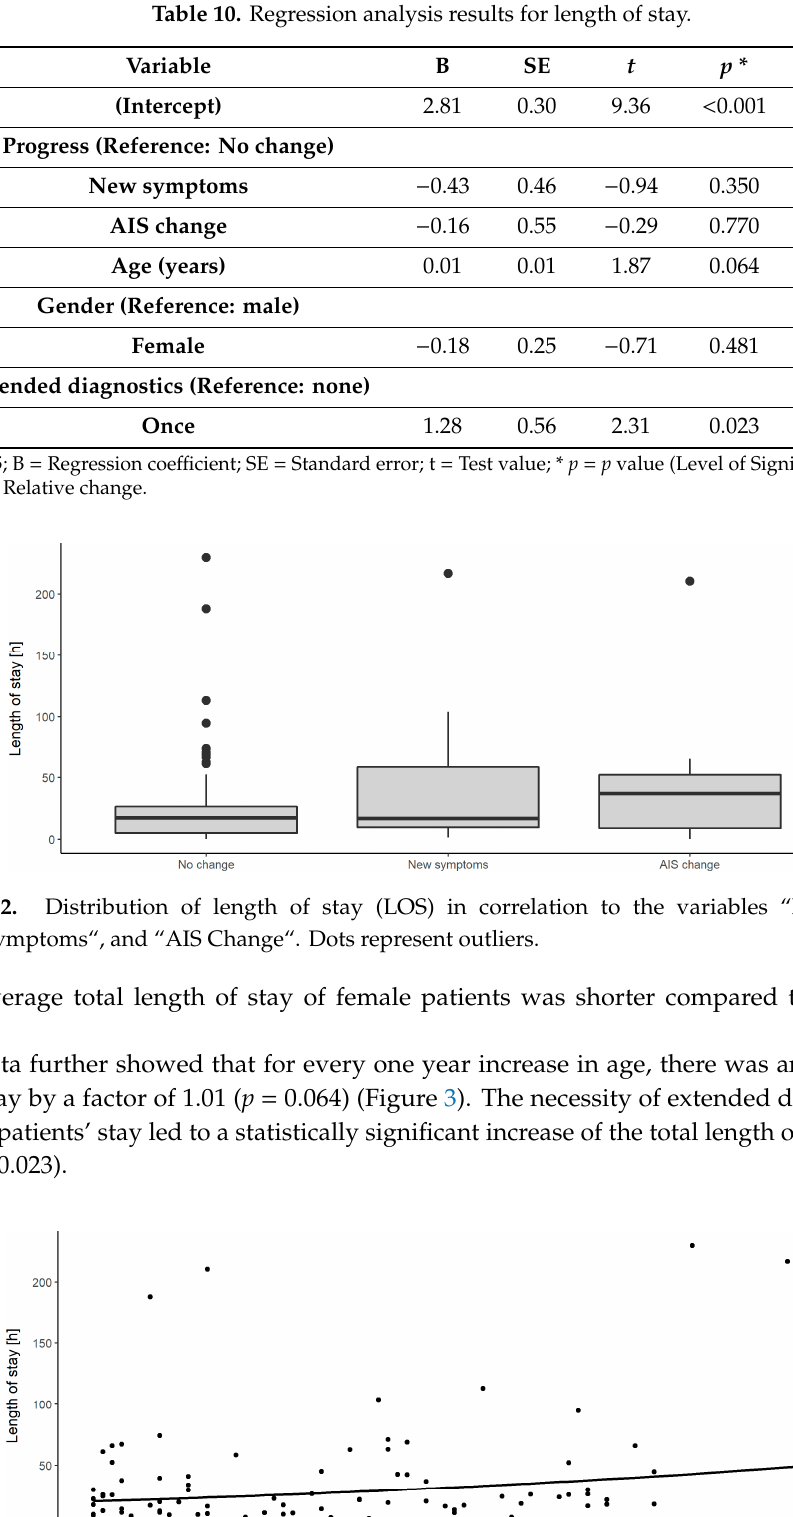
Figure 3. Correlation between length of stay and age of patients. The solid line (regression line) represents the correlation according to the transformed regression coefficient (Table 10).